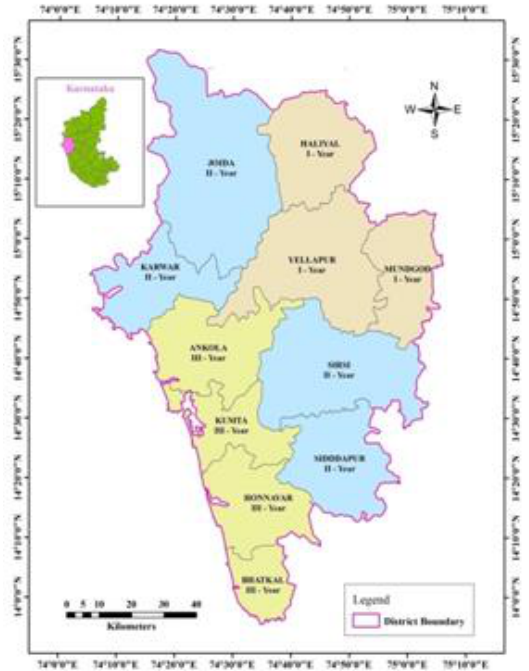
Figure 1. Study area of Uttara Kannda district.